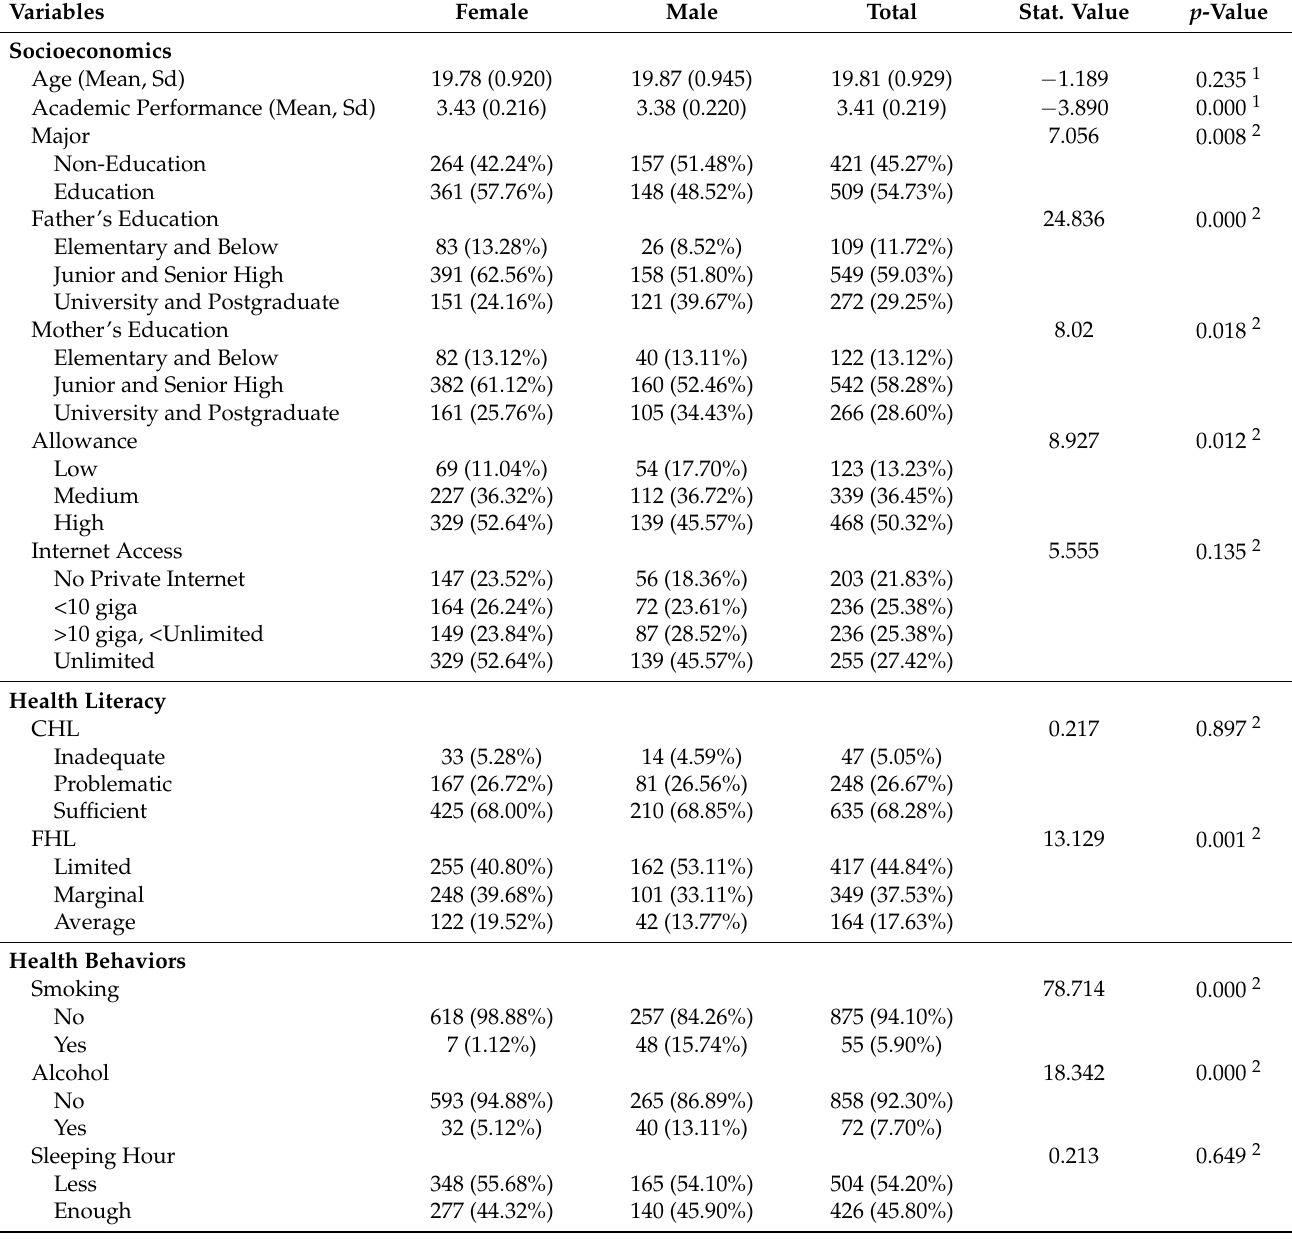
Table 1. Descriptive statistics of the respondents in the study by